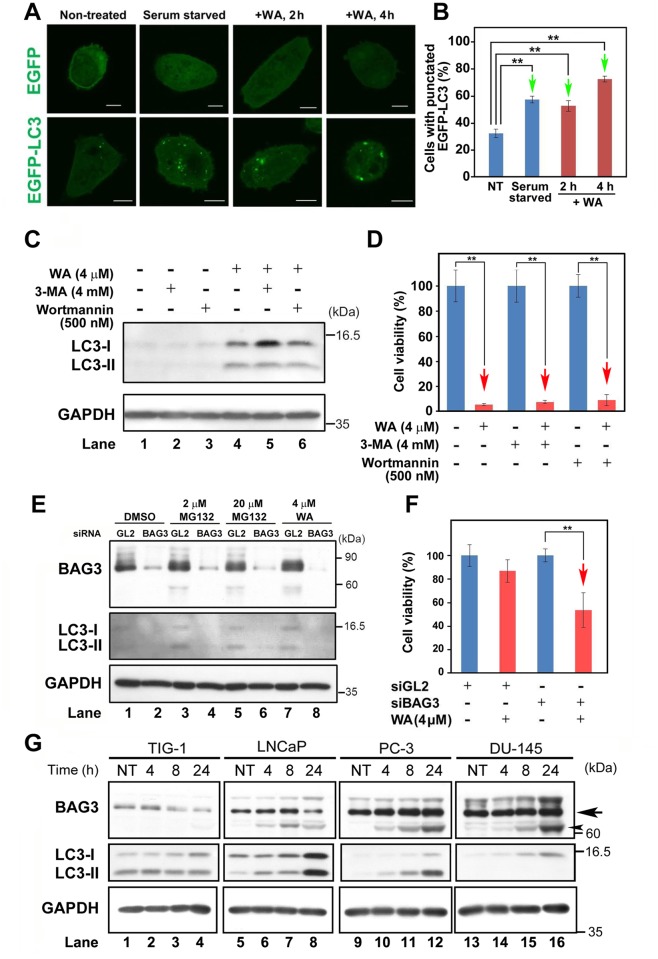
WA induces BAG3-mediated autophagy in PC-3 cells.A) Observation of EGFP and EGFP-LC3 signals by immunofluorescence microscopy. Bar, 10 μm. (B) Bar graphs showing the percentage of cells containing punctate EGFP-LC3; arrows show that the values gradually increased under the indicated conditions. Data are represented as the means ± SEM of three independent experiments; green arrows indicate statistically significant increases (**, P < 0.01). (C) Western blot analysis to detect LC-3 and GAPDH (loading control) in PC-3 under the indicated conditions. (D) Bar graphs showing cell viability (%) under the indicated conditions. (E) Western blot analysis to detect BAG3, LC-3, and GAPDH (loading control) in PC-3 cells in the presence of the indicated conditions of siBAG3 or siGL2 (negative control). (F) Bar graphs showing cell viability (%) at the indicated conditions. (D, F) Data are represented as means ± SEM of three independent experiments; red arrows indicate statistically significant reductions in cell viability (**, P < 0.01). (A–F) Samples were collected at 4 h after WA treatment. (G) Expression profiles of the autophagy-related proteins BAG3 and LC3 in PC-3 cells at 4, 8, and 24 h after treatment with 4 μM WA. NT: non-treated.